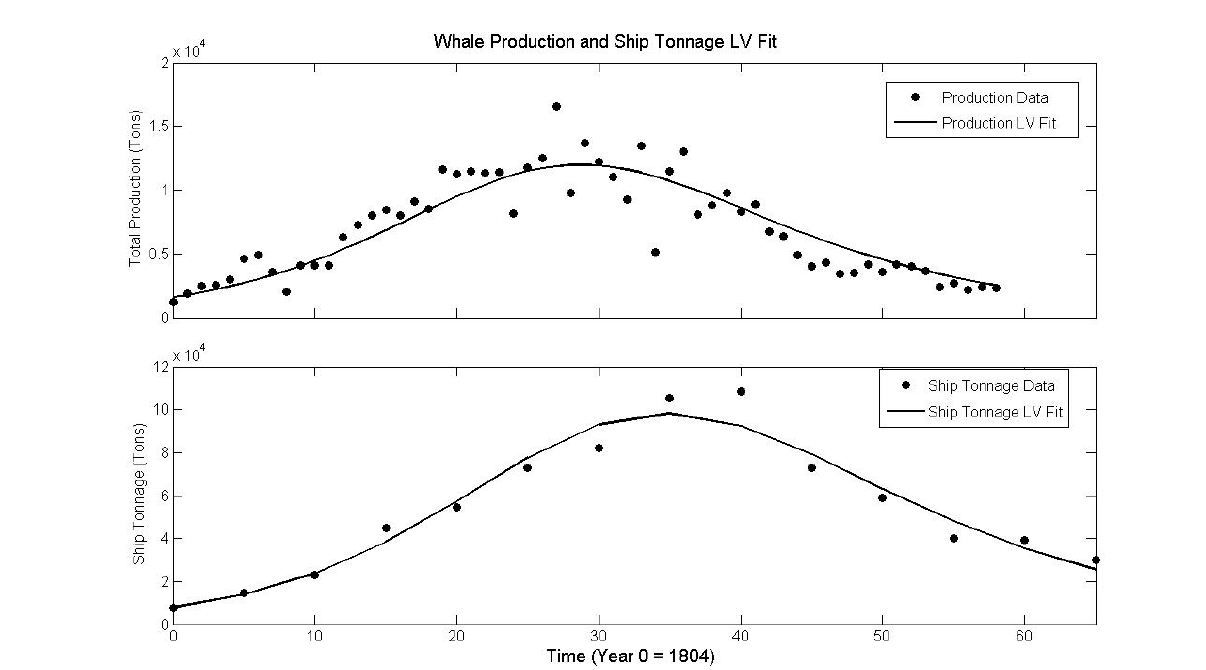
Figure 5 . Data for whaling in 19 th century fitted by the model developed in the present study. In this case, the resource is whale oil, while a measure of the capital invested in production can be taken as proportional to the total tonnage of the whaling vessels. Data are from